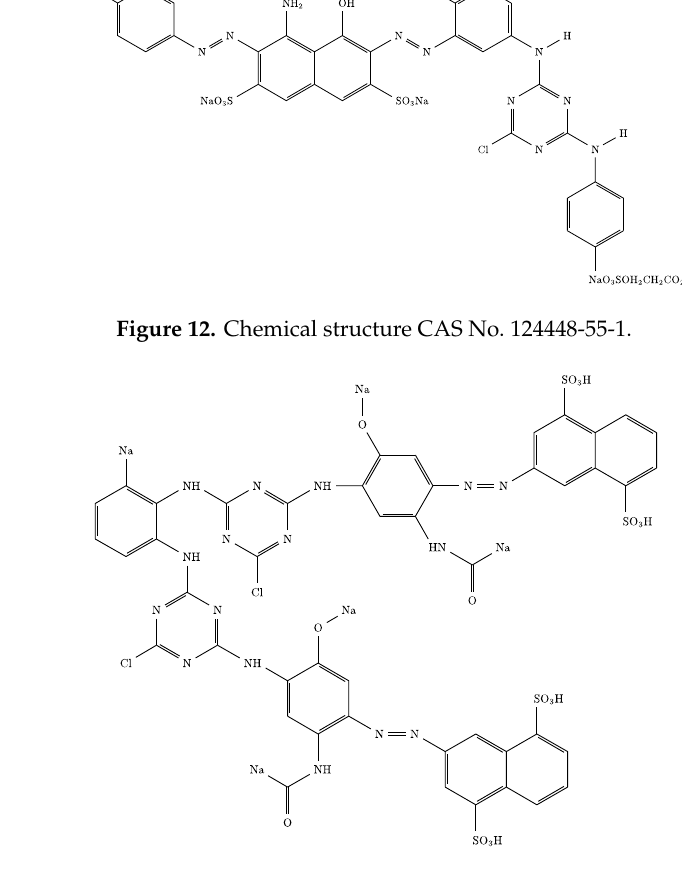
Figure 13. Chemical structure CAS No. 72916-24-2.